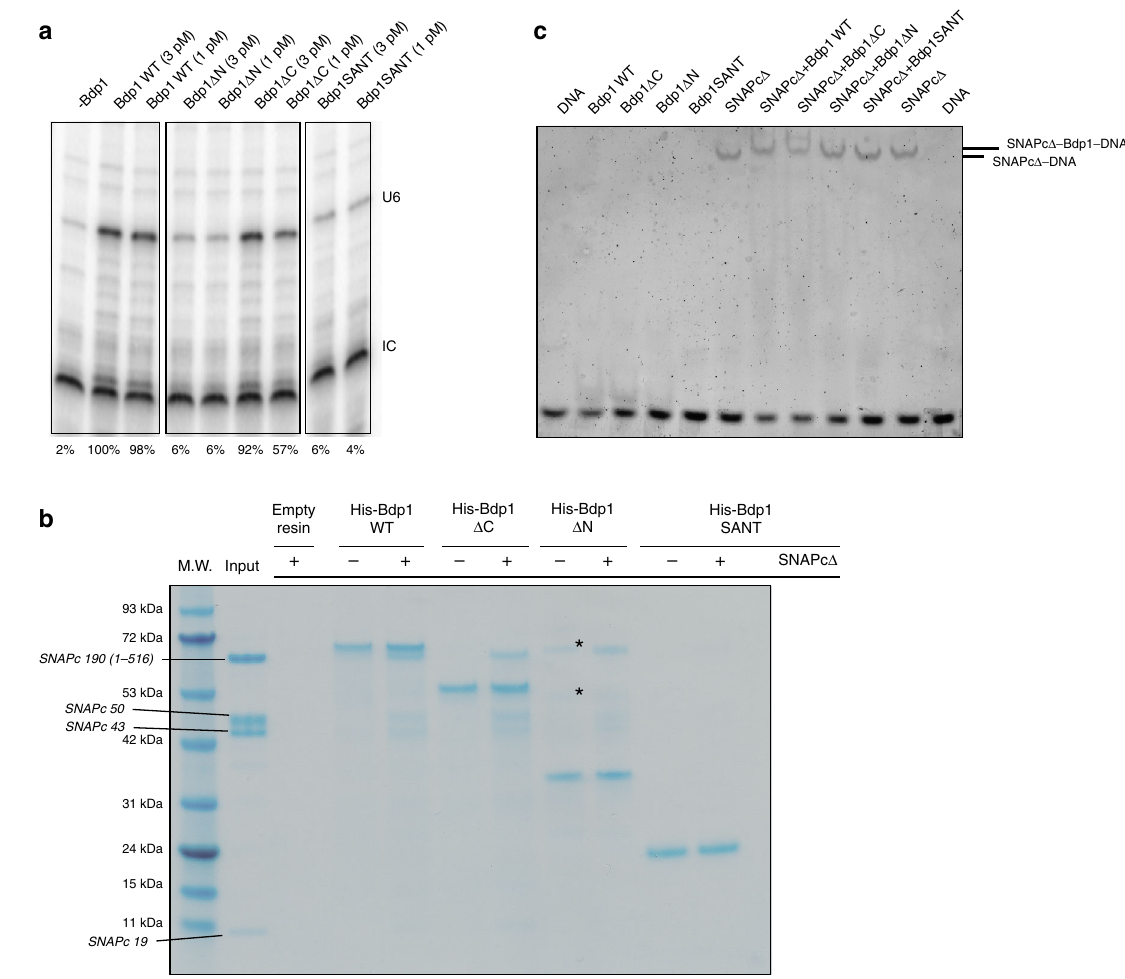
Fig. 6 Functional characterization of the Bdp1 N-terminal and C-terminal regions. a Deletion of N-terminal and C-terminal regions of Bdp1 reduces U6 transcription in vitro. IC is the internal loading control. The values at the bottom represent the % of the normalized intensities relative to the wild-type Bdp1 sample. The IC band was used for normalization. b Pull-down assay using immobilized Bdp1 constructs showing that deletion of N-terminal and C-terminal regions of Bdp1 reduces binding of Bdp1 to SNAPc in absence of the DNA. The composition of the SNAPc Δ is shown as a control in the input lane with the SNAPc Δ subunits labeled aside the molecular weight (M.W.) standards lane . *Indicates uncharacterized contaminants in the Bdp1- Δ N preparation. c EMSA showing that deletion of N-terminal and C-terminal regions of Bdp1 reduces binding of Bdp1 to SNAPc in presence of the